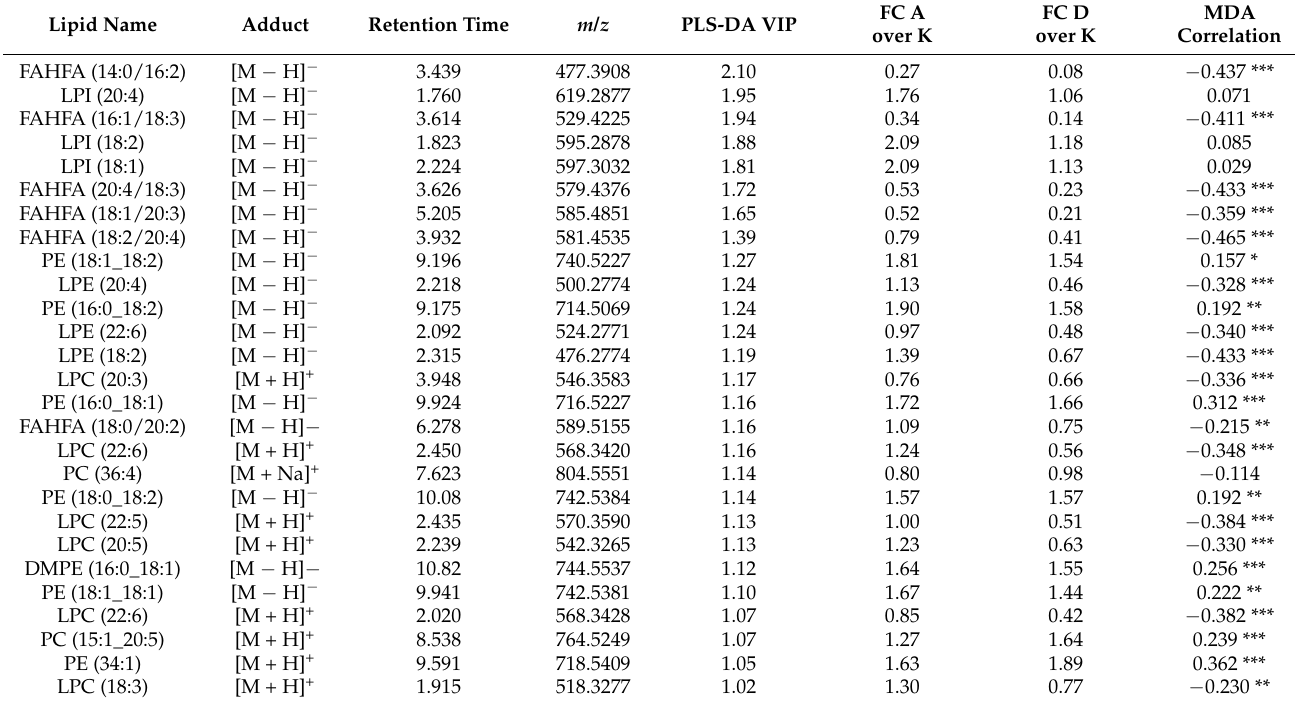
Table 2. Significant (VIP) lipids obtained by the PLS-DA model on the set of polar lipids.